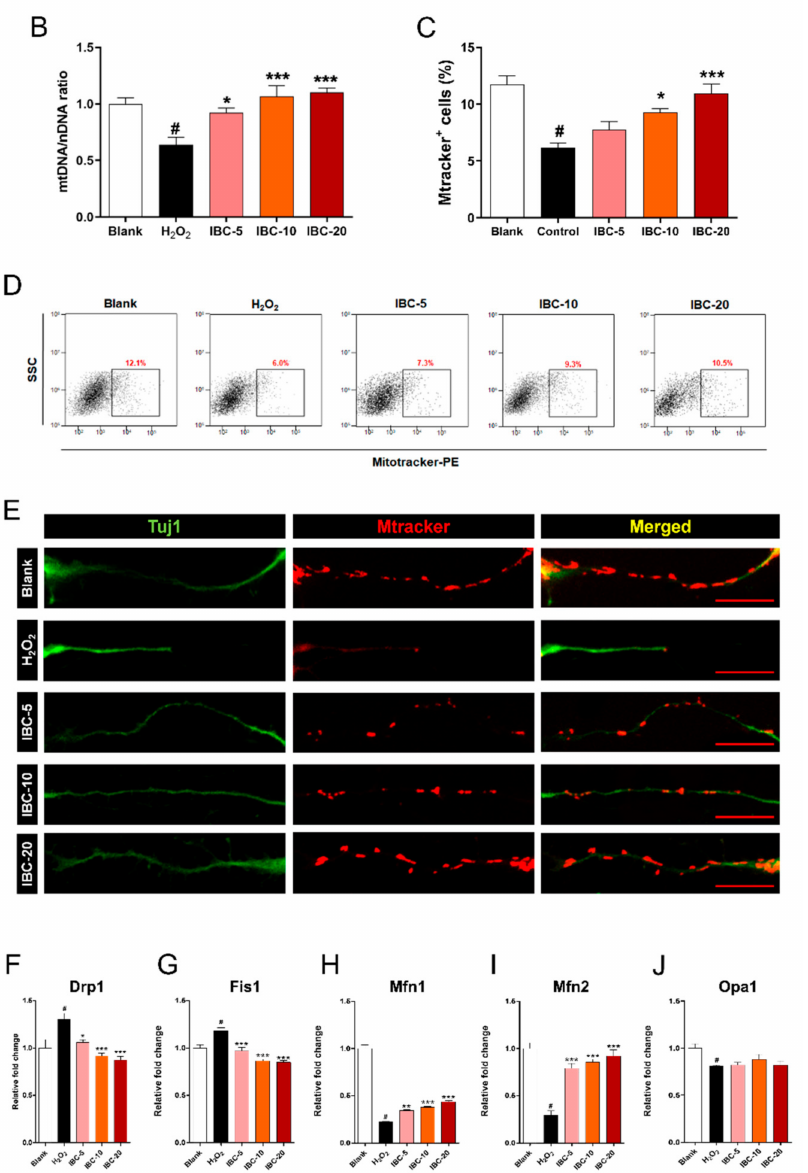
Figure 3. Effect of IBC extract on mitochondrial amount and morphology following H 2 O 2 -induced oxidative stress injury in rat primary cortical neurons. ( A ) Representative images showing expression of Mitotracker marker in IBC-treated neurons. White scale bar = 50 µ m, Red scale bar = 10 µ m. ( B ) Analysis of mtDNA/nDNA ratio by quantitative real-time PCR (n = 6). ( C ) Quantification of Mitotracker-positive cells at the single-cell level by flow cytometry (n = 4). ( D ) Representative flow cytometric dot plots graphs showing Mitotracker expression. ( E ) High magnified images showing mitochondria within axons. Red scale bar = 10 µ m. ( F – J ) Expression of mitochondrial fission and fusion-related genes by qRT-PCR (n = 6); ( F ) Drp1 , ( G ) Fis1 , ( H ) Mfn1 , ( I ) Mfn2 and ( J ) Opa1 . Data are expressed as the means ± SEM. Significant differences indicated as # p < 0.001 compared vs. the blank group, * p < 0.05, ** p < 0.01 and *** p < 0.001 vs. the H 2 O 2 group were analyzed via one-way ANOVA with Tukey’s post hoc